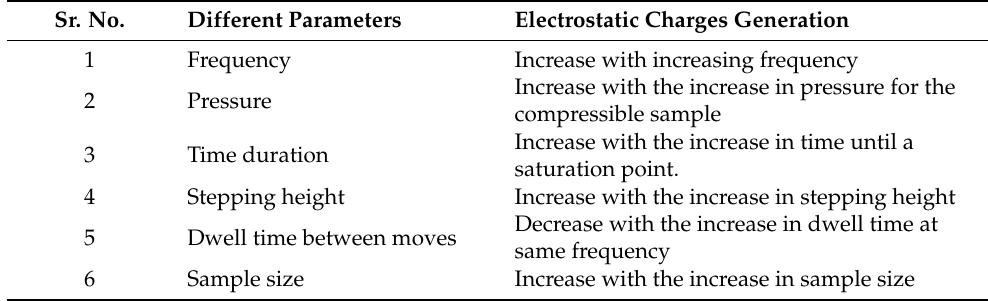
Table 7. Effect of different parameters on the electrostatic charge